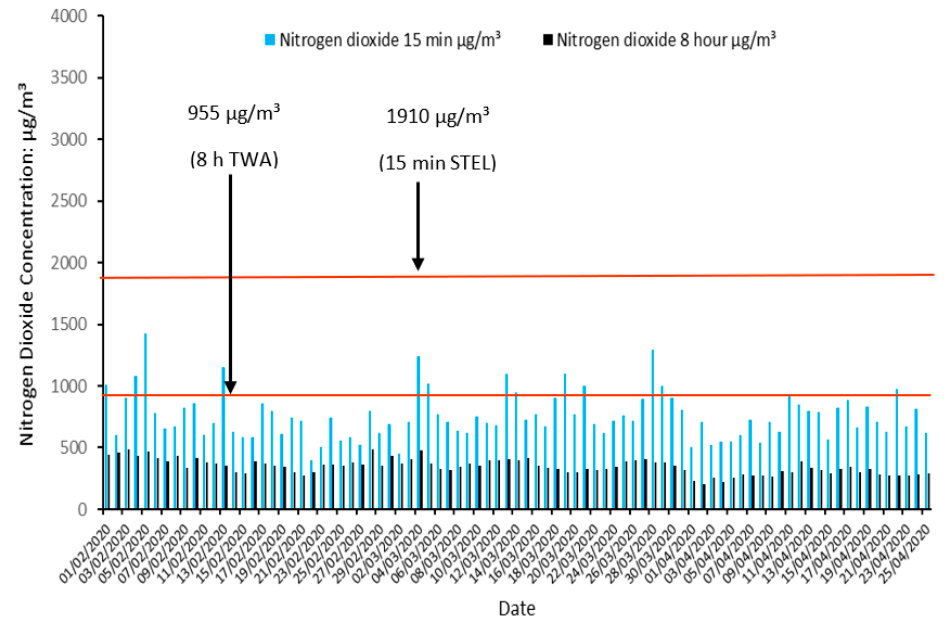
Figure 5. Retrospective assessment of nitrogen dioxide concentrations on Platform 10B in Birmingham New Street Station in comparison with the Workplace Exposure Limits.